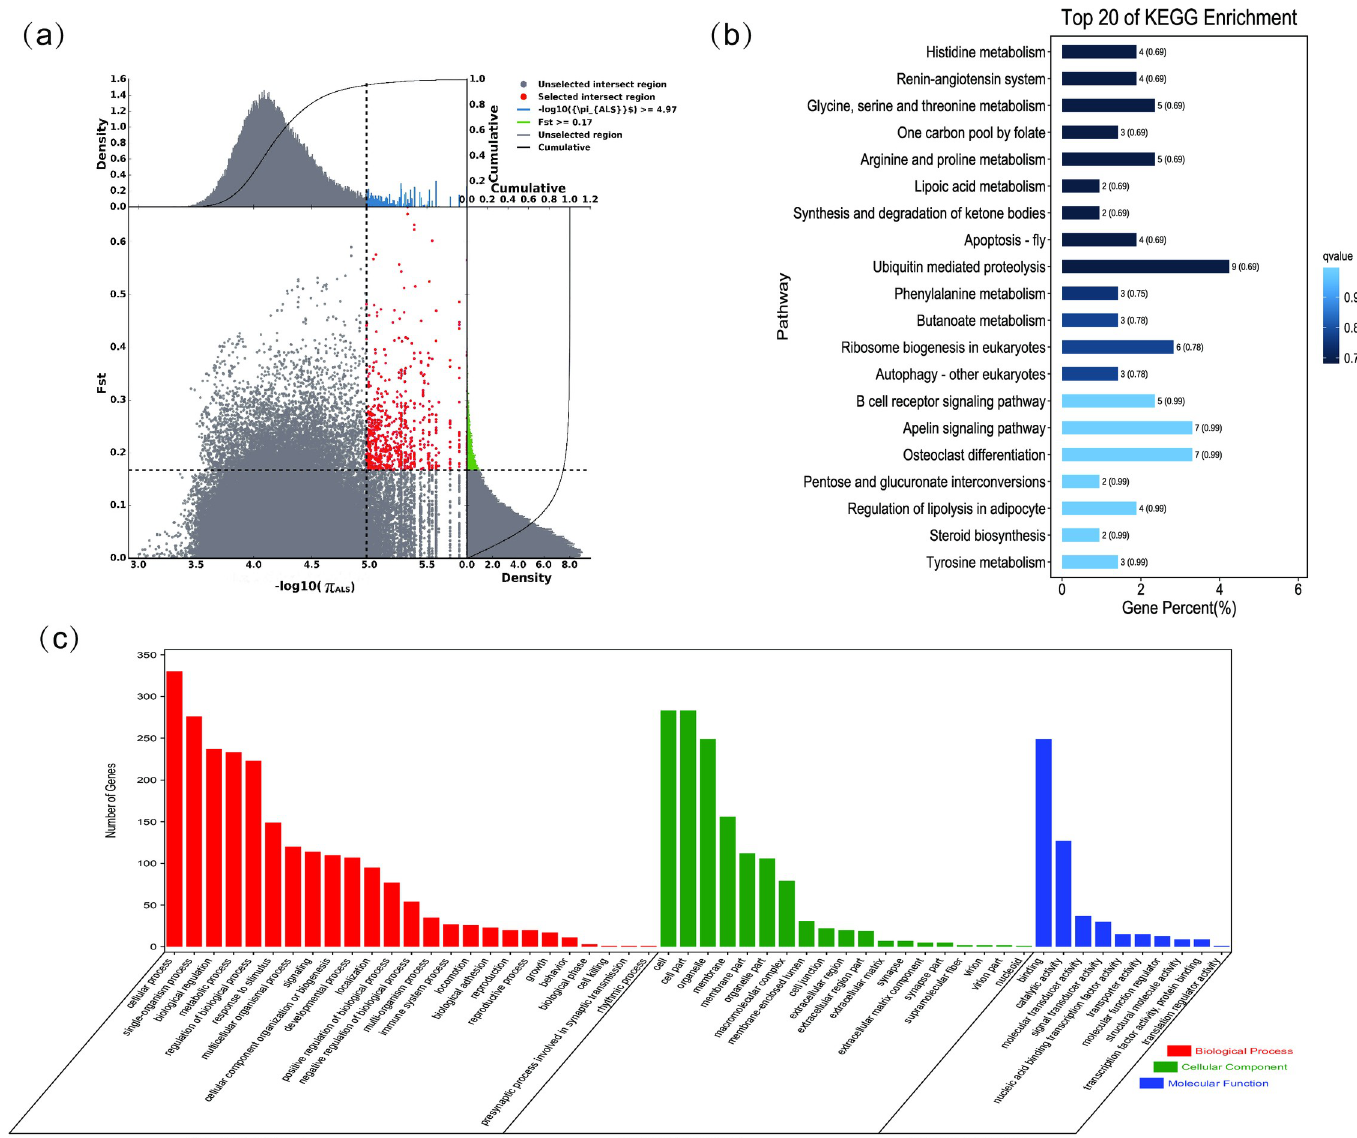
Fig 4. GO classification and KEGG enrichment of the selected genes of Alashan camels. (a) With the pool of all remaining others as the reference population and Alashan camels as the target population, 622 selected genes were obtained. (b) KEGG enrichment of 622 selected genes of Alashan camels. (c) GO classification of 622 selected genes of Alashan